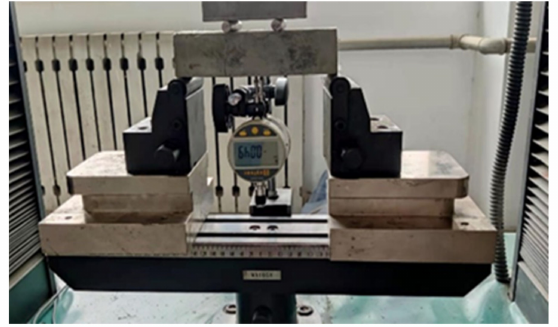
Figure 3. UTM − 5105 testing machine.